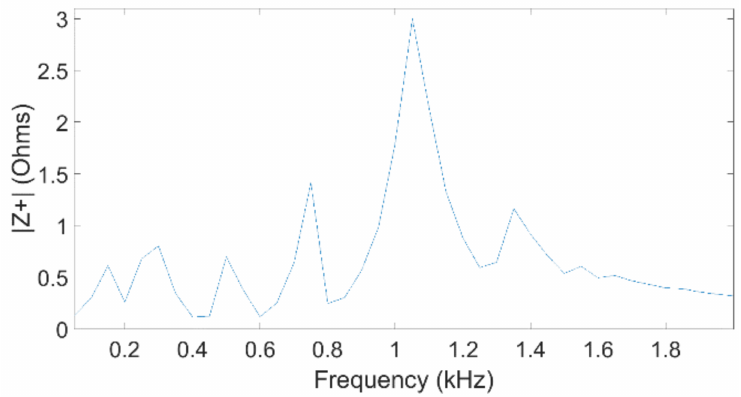
Figure A3. Impedance of the public grid as a function of